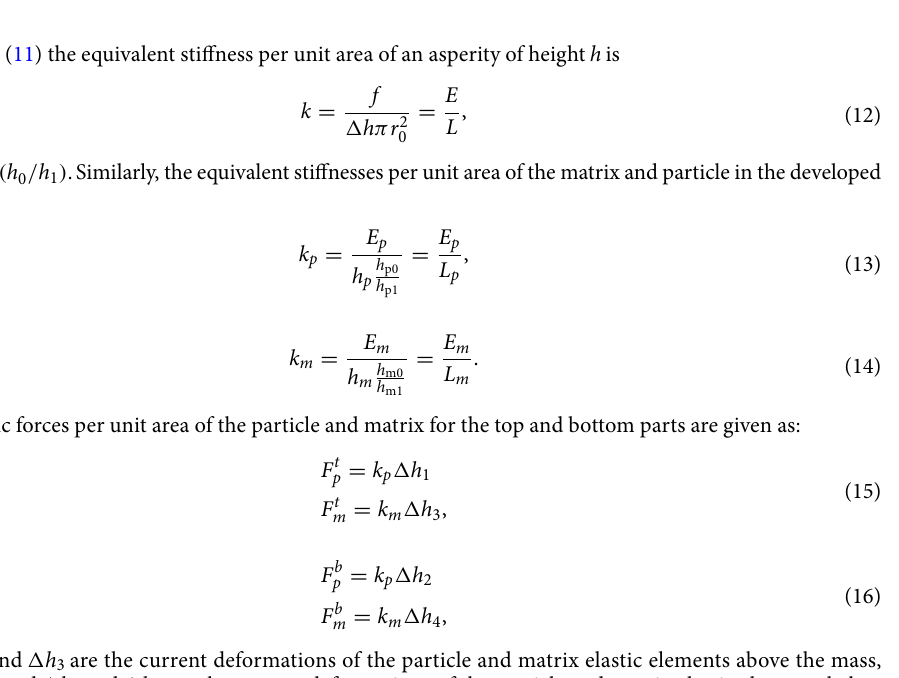
Table 1. The values in the model are for the case of CNC reinforced PA610. The mass per unit area, m , of the CNC particles is derived from the density and size of the spherical particle (Diameter, D = 100 nm) from the